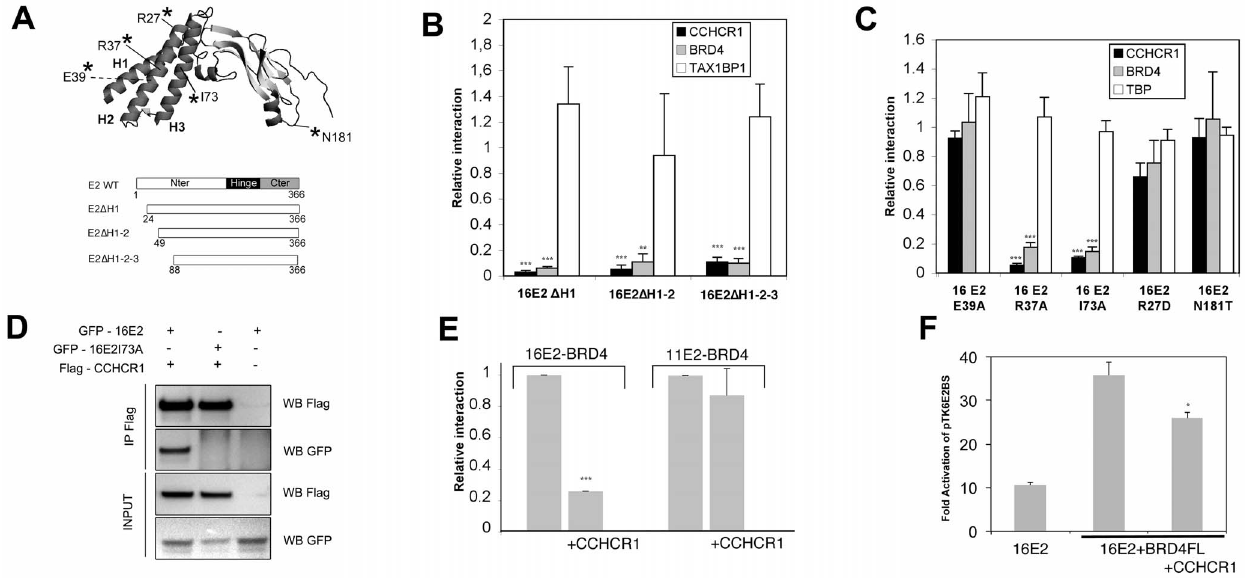
Figure 2. Mapping of the CCHCR1 binding interface on HPV16 E2. (A) top: schematic representation of HPV16 E2 N-terminal domain picturing the position of point mutations used. The E39 amino acid is shown with a dot line since it faces the opposite side of the helices. H1, H2, H3 are respectively alpha-helix 1, 2 and 3. Bottom: diagrams of the HPV16 E2 deletion mutants. (B) Interactions between HPV16 E2 deletion mutants and CCHCR1, BRD4 and TAX1BP1 tested by GPCA. Results are represented relative to the interaction with wild type HPV16 E2. **, p , 0.01; ***, p , 0.001 versus the interaction with the wild type HPV16 E2. (C) Interaction between HPV16 E2 point mutants and CCHCR1, BRD4 and TBP tested by GPCA. Results are represented as relative to the interaction with the wild type HPV16 E2 protein. ***, p , 0.001 versus the interaction with the wild type HPV16 E2. (D) 293 T cells were co-transfected with expression plasmids for Flag-CCHCR1 and GFP-HPV16 E2 WT or I73A as indicated. Cell were lysed and subjected to immunoprecipitation (IP) using anti FLAG antibody followed by western Blotting (WB) with anti FLAG or anti GFP antibodies as indicated. (E) Interaction between HPV16 E2 or HPV11 E2 and BRD4 was assessed in GPCA, in the presence of CCHCR1 as a challenging protein where indicated. Results are reported to NLR values obtained when an empty plasmid was used instead of the challenging protein. ***, p , 0.001 versus the interaction without CCHCR1 as a challenger. (F) HaCaT cells were transfected with an E2-reponsive luciferase reporter plasmid (pTK6E2BS) in the presence of HPV16 E2, BRD4 plus CCHCR1 where indicated. Fold activation are given relative to promoter activity without E2; *, p , 0.05 versus experiments without CCHCR1.